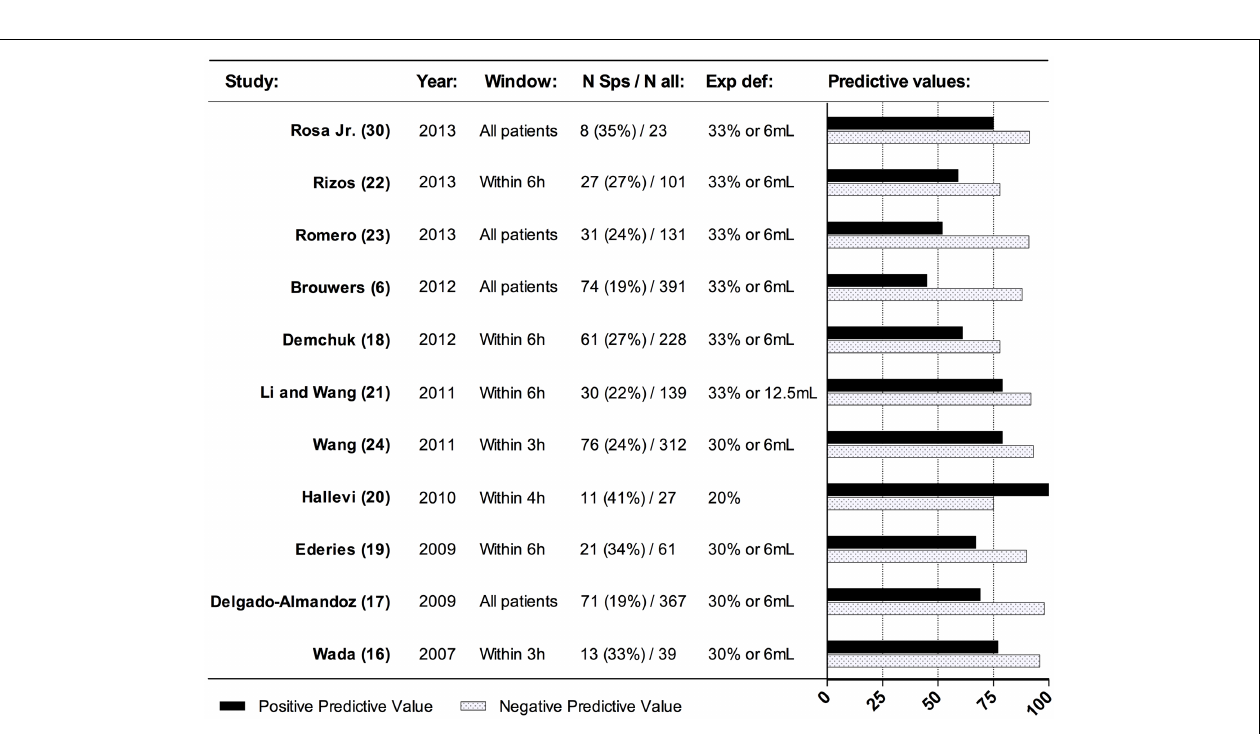
FIGURE 3 | Effect of contrast extravasation on hematoma expansion .This figure presents the predictive values across studies for contrast extravasation to predict hematoma expansion.The predictive values indicated the independent effect of contrast extravasation and